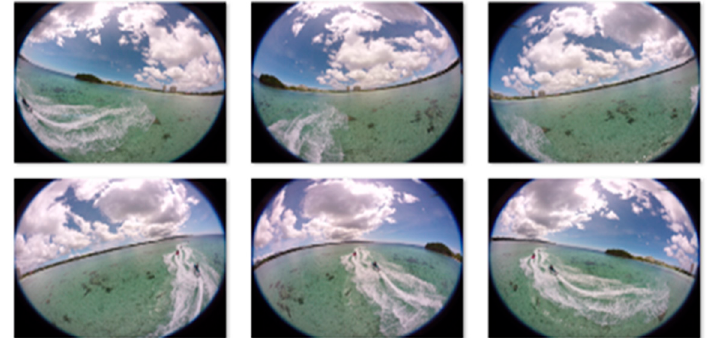
Figure 5. Representative captured images from drone-mounted cameras for mono panorama generation.